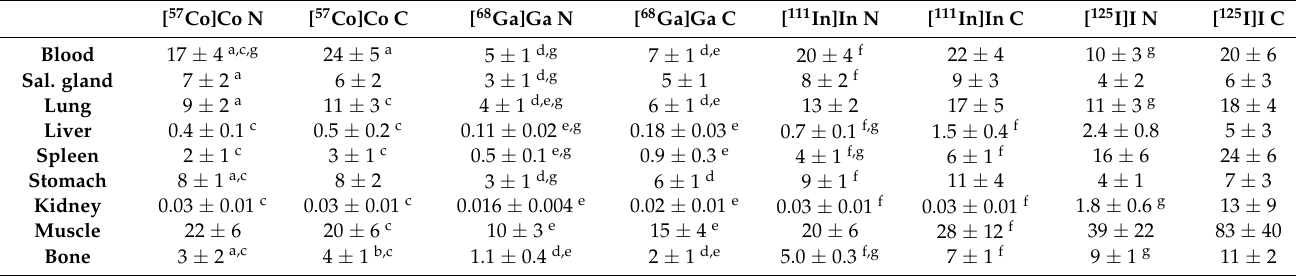
a Significant difference ( p < 0.05) between [ 57 Co]Co and [ 68 Ga]Ga. b Significant difference ( p < 0.05) between [ 57 Co]Co and [ 111 In]In. c Significant difference ( p < 0.05) between [ 57 Co]Co and [ 125 I]I. d Significant difference ( p < 0.05) between [ 68 Ga]Ga and [ 111 In]In. e Significant difference ( p < 0.05) between [ 68 Ga]Ga and [ 125 I]I. f Significant difference ( p < 0.05) between [ 111 In]In and [ 125 I]I. g Significant difference between N - and C -terminal placement of the label (unpaired t